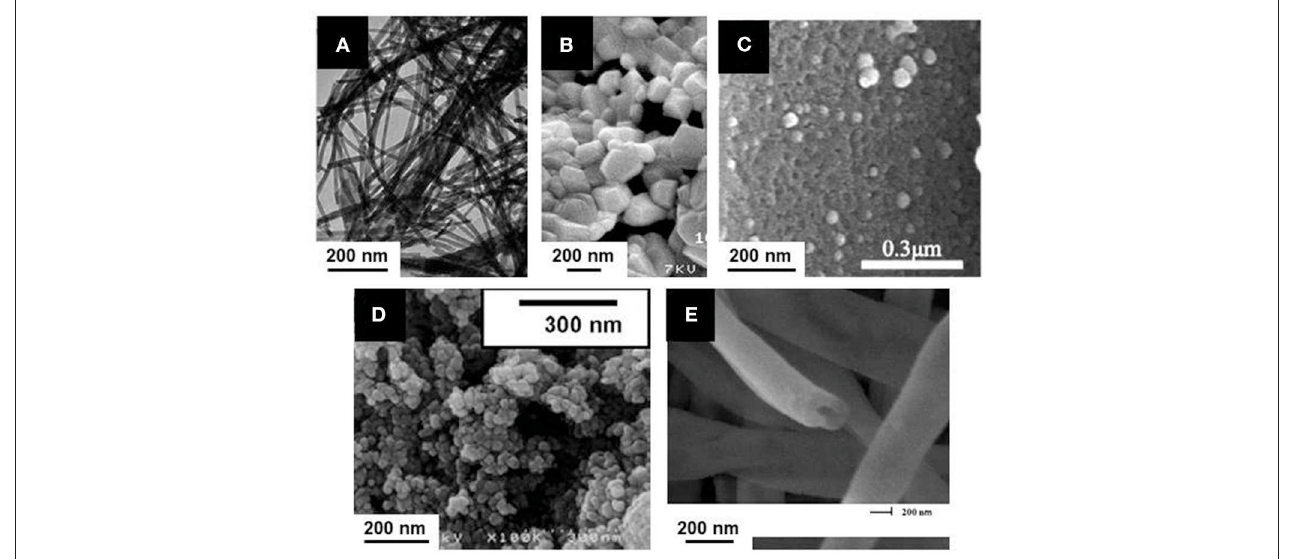
FIGURE 8 | Ln 2 O 2 S nanoparticles obtained from unconventional synthetic methods: (A) Boron-sulfur method (La 2 O 2 S:Eu nanowires); Adapted with permission from (Huang et al., 2008), copyright (2008) American Chemical Society. (B) Combustion (La 2 O 2 S:Yb, Er nanoparticles); Adapted from Hakmeh et al. (2015) with permission of Elsevier. (C) Thermal decomposition of a gel of Pomelo skins (Ce 2 O 2 S nanoparticles supported on carbon); Adapted with permission from Yang et al. (2017), copyright (2017) American Chemical Society. (D) Emulsion liquid membrane system (Y 2 O 2 S:Yb, Er nanoparticles); Adapted with permission from Hirai et al. (2002), copyright (2002) American Chemical Society. (E) Electrospinning (Y 2 O 2 S: Yb, Er hollow nanofiber). Adapted from Han et al. (2015a) with permission of The Royal Society of